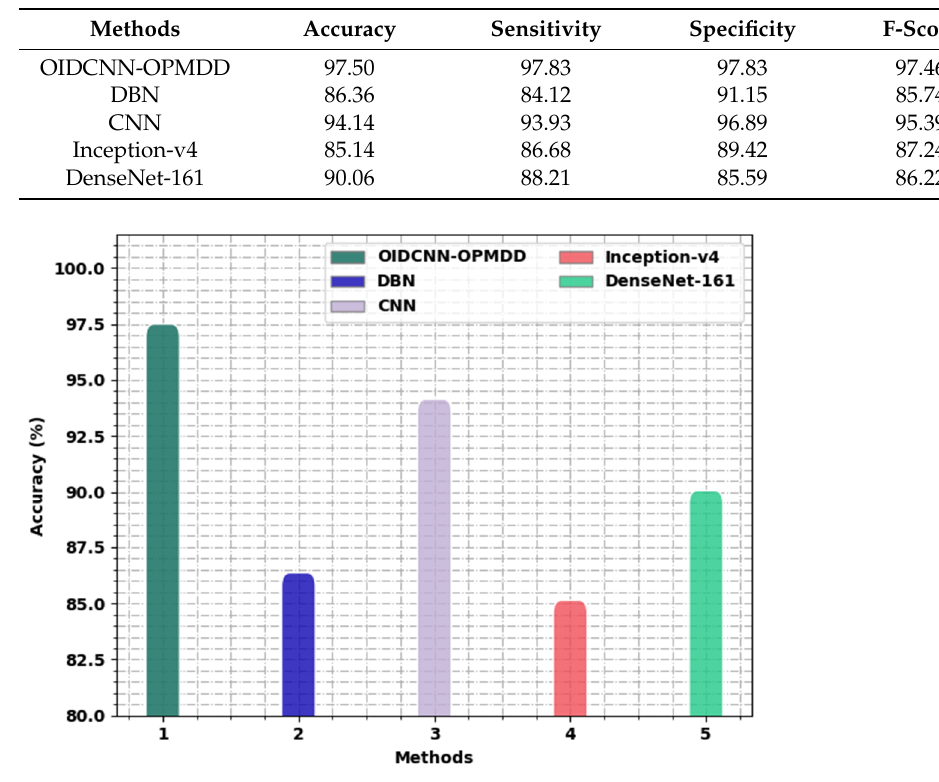
Figure 13. Sens_y analysis of the OIDCNN-OPMDD approach with existing algorithms. Figure 14 displays the detailed study of the OIDCNN-OPMDD approach with exist- ing algorithms in terms of (cid:1871)(cid:1868)(cid:1857)(cid:1855) (cid:3052) . These results implicit the ineffectual outcome of the In- ception-v4 technique with a minimal (cid:1871)(cid:1868)(cid:1857)(cid:1855) (cid:3052) of 89.42%, whereas the DBN approach man- aged to report a slightly improved (cid:1871)(cid:1868)(cid:1857)(cid:1855) (cid:3052) of 91.15%. In addition, the DenseNet-161 meth- odology reached reasonable outcomes with (cid:1853) (cid:1871)(cid:1868)(cid:1857)(cid:1855) (cid:3052) of 85.59%. Then, the CNN algorithm resulted in notable performance with a (cid:1871)(cid:1868)(cid:1857)(cid:1855) (cid:3052) of 96.89%. However, the OIDCNN-OP- MDD methodology outperformed the others with an increased (cid:1871)(cid:1868)(cid:1857)(cid:1855) (cid:3052) of 97.83%. Figure 15 exemplifies the comprehensive inception of the OIDCNN-OPMDD algo- rithm with existing models in terms of (cid:1832) (cid:3046)(cid:3030)(cid:3042)(cid:3045)(cid:3032) . These results denoted the ineffectual out- come of the Inception-v4 technique with a minimal (cid:1832) (cid:3046)(cid:3030)(cid:3042)(cid:3045)(cid:3032) of 87.24%, whereas the DBN approach managed to report a slightly improved (cid:1832) (cid:3046)(cid:3030)(cid:3042)(cid:3045)(cid:3032) of 85.74%. Moreover, the Dense- Net-161 methodology reached reasonable outcomes with (cid:1853) (cid:1832) (cid:3046)(cid:3030)(cid:3042)(cid:3045)(cid:3032) of 86.22%. Next, the CNN technique resulted in notable performance with a (cid:1832) (cid:3046)(cid:3030)(cid:3042)(cid:3045)(cid:3032) of 95.39%. However, the